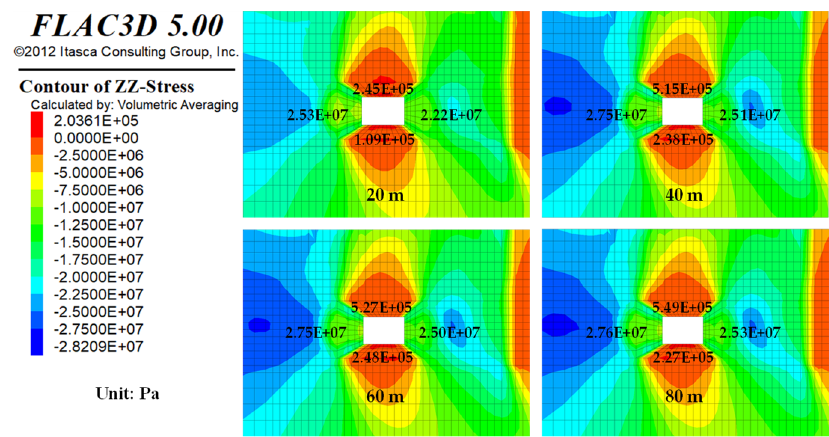
Figure 6. The influence of boundary effects on the stress of the model.